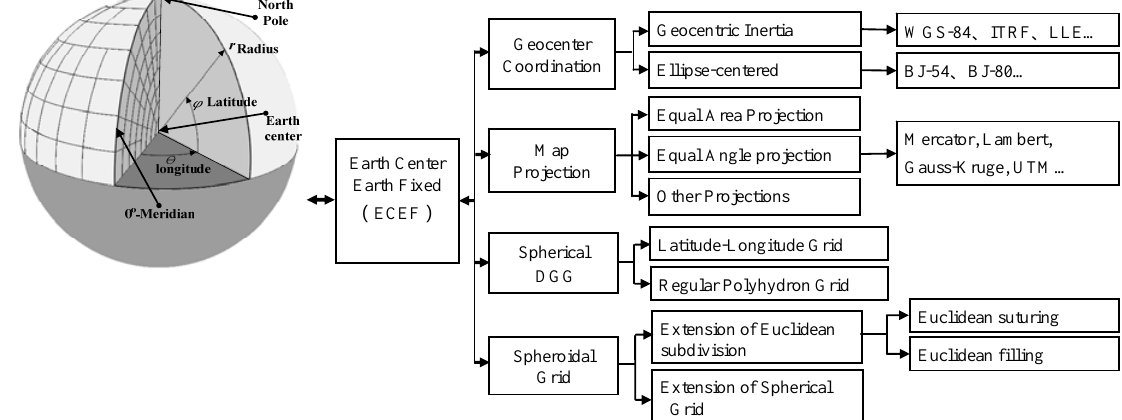
Fig. 2 Link of ESSG with other spatial reference frames